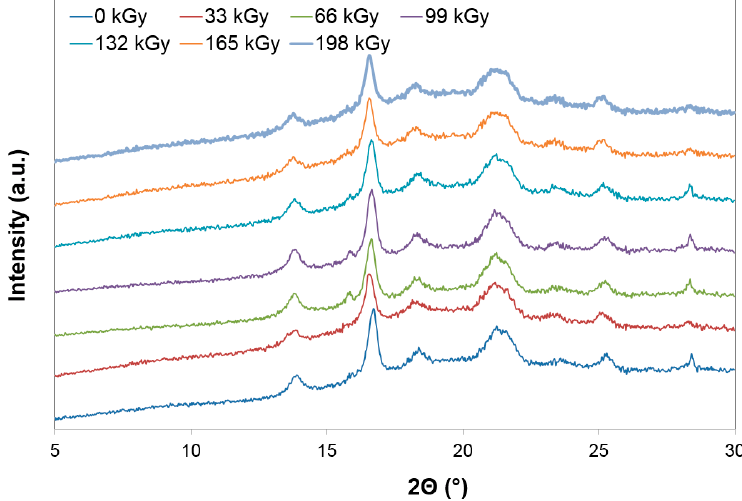
Figure 15. X-ray diffraction—Technical polymers (PP 30% GF).